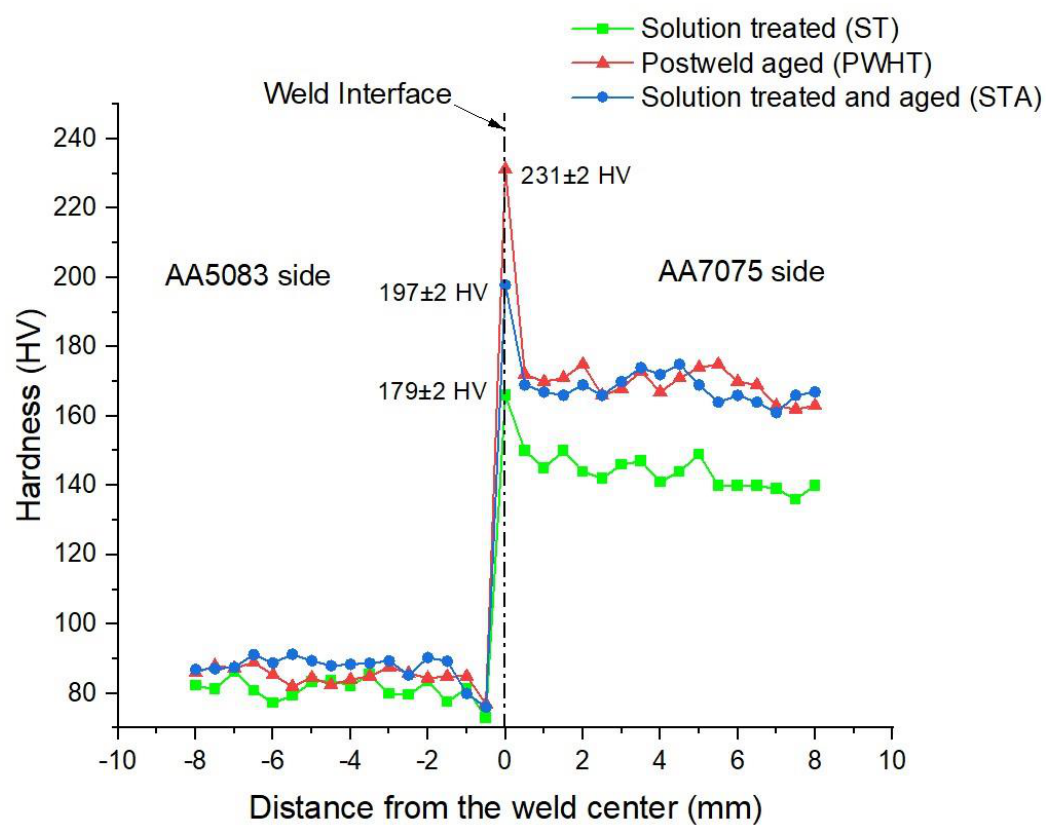
Figure 12. Hardness distribution across the weld interface for all heat treatment conditions.